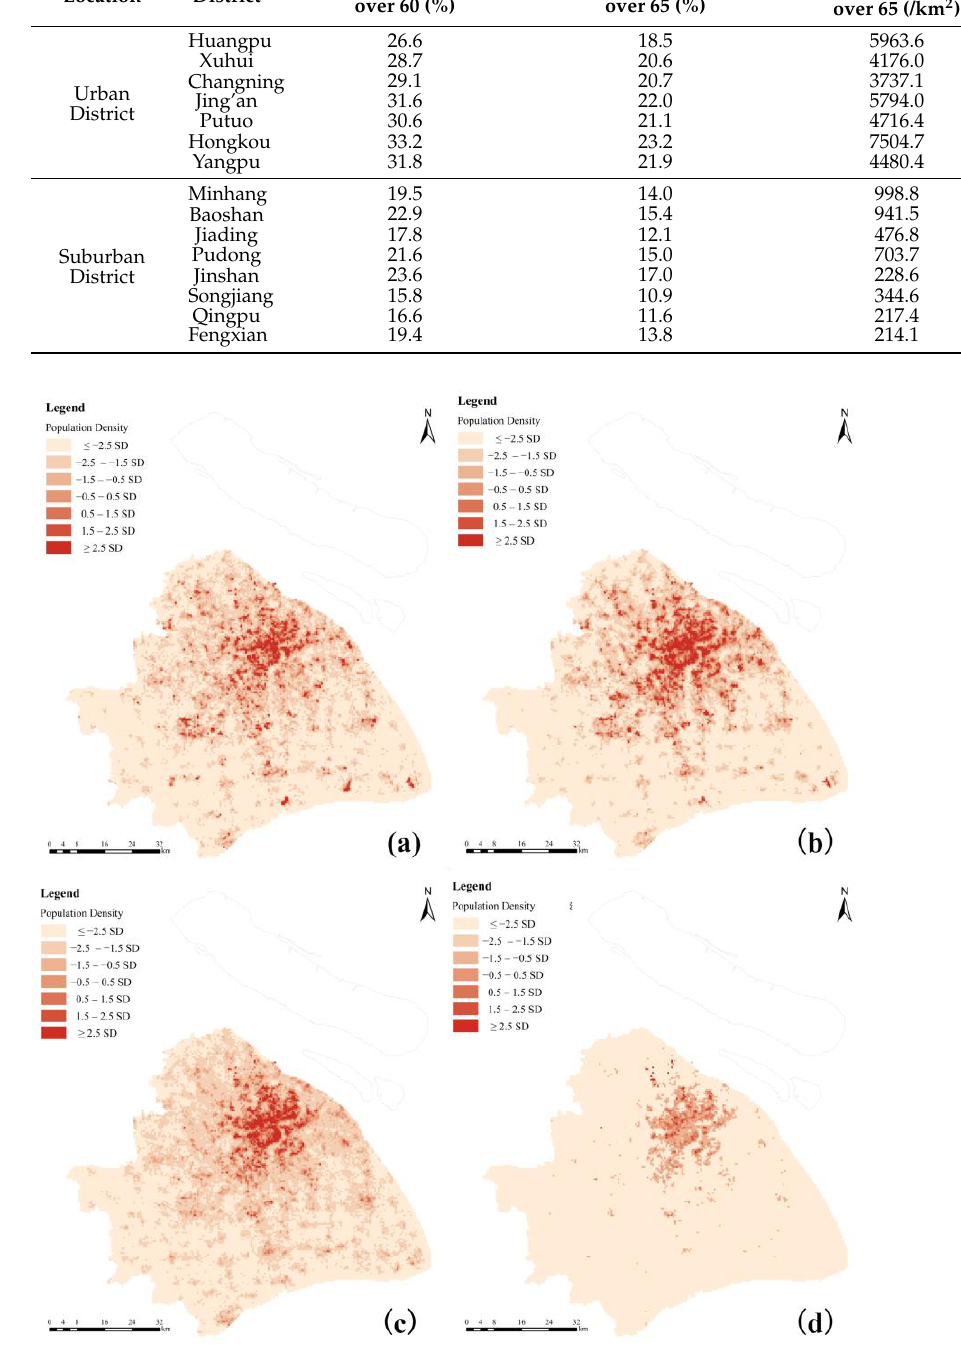
Figure 9. Spatial distribution of residence for ( a ) juvenile ( ≤ 18), ( b ) young (19–44), ( c ) middle age (45–64), and ( d ) elderly ( ≥